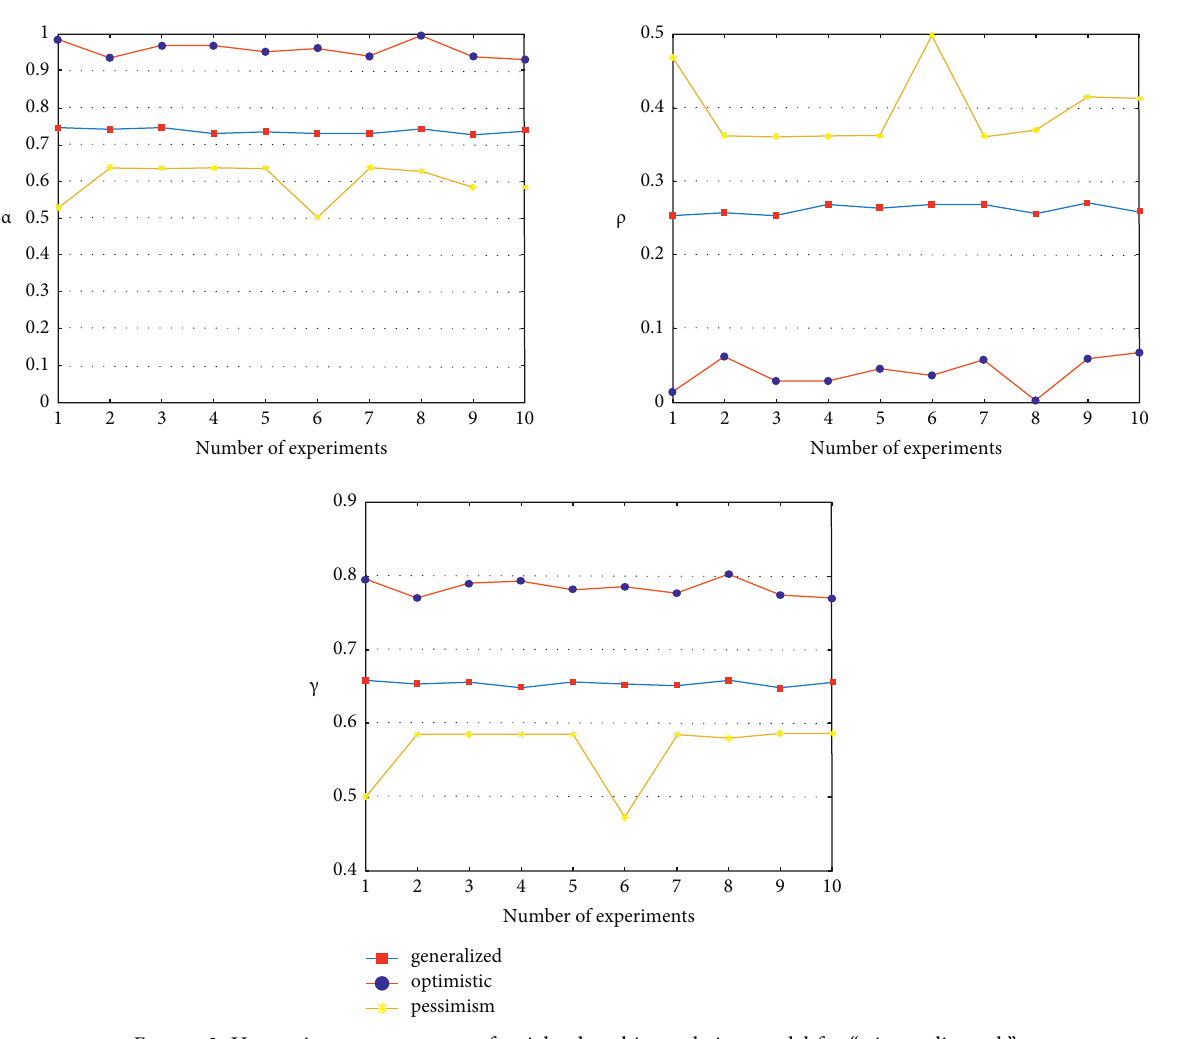
Figure 3: Uncertainty measurement of weighted multigranulation model for